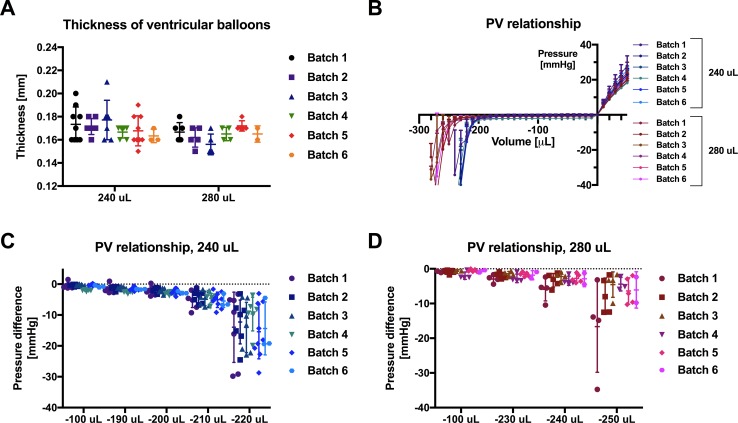
Baseline characteristics of ventricular balloons.(A) Thickness of ventricular balloons (VB); (B) PV relationship of VBs according to batch; (C) pressure for all 240 μL VBs at volumes of -100, -190, -200, -210, -220 μL; (D) pressure for all 280 μL VBs at volumes of -100, -230, -240, -250 μL. Data are normalized to initial pressure (volume = 0) and expressed as mean ± SD. n = 2–9 per group.